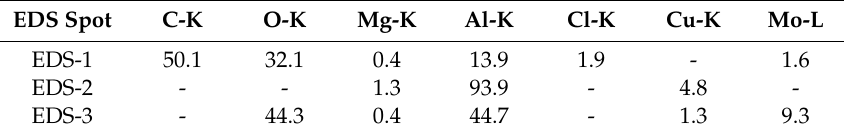
Figure 15. EDS spectra for the fracture surface of ( a ) epoxy resin and ( b , c ) aluminium alloy sheet. Table 3. Chemical composition of the locations identified in Figure 12, wt%.